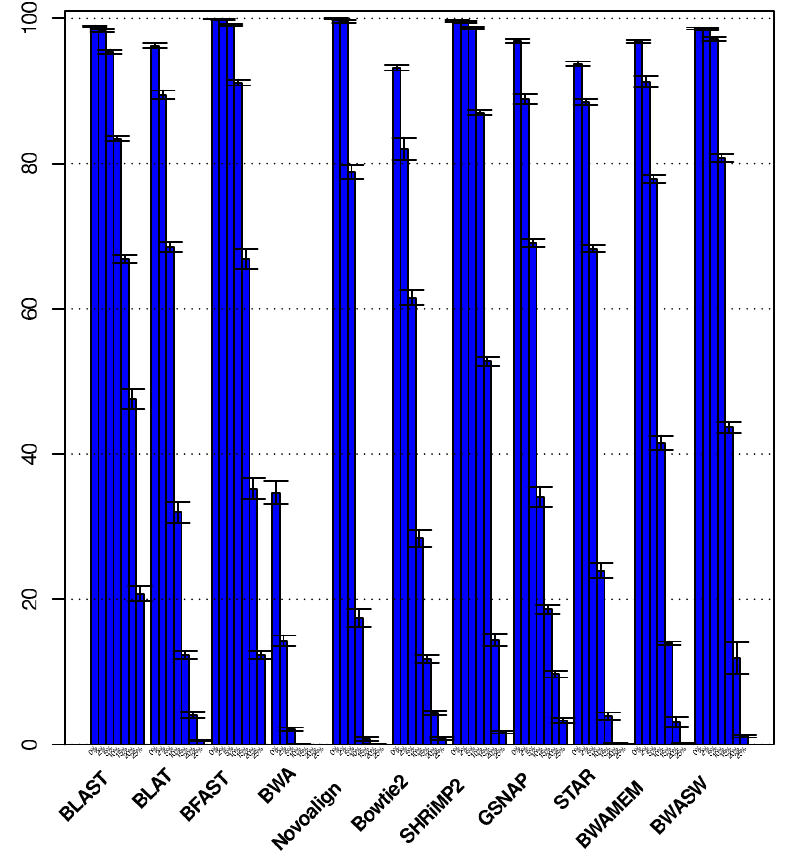
Figure 3. Histogram plot of the number of aligned reads as a function of the viral mutation rate. Histogram plot of the number of aligned reads as a function of the mutation rate for each aligner averaged over the four viral genomes (see Table 1). the Materials and Methods section for simulated viral sequences.